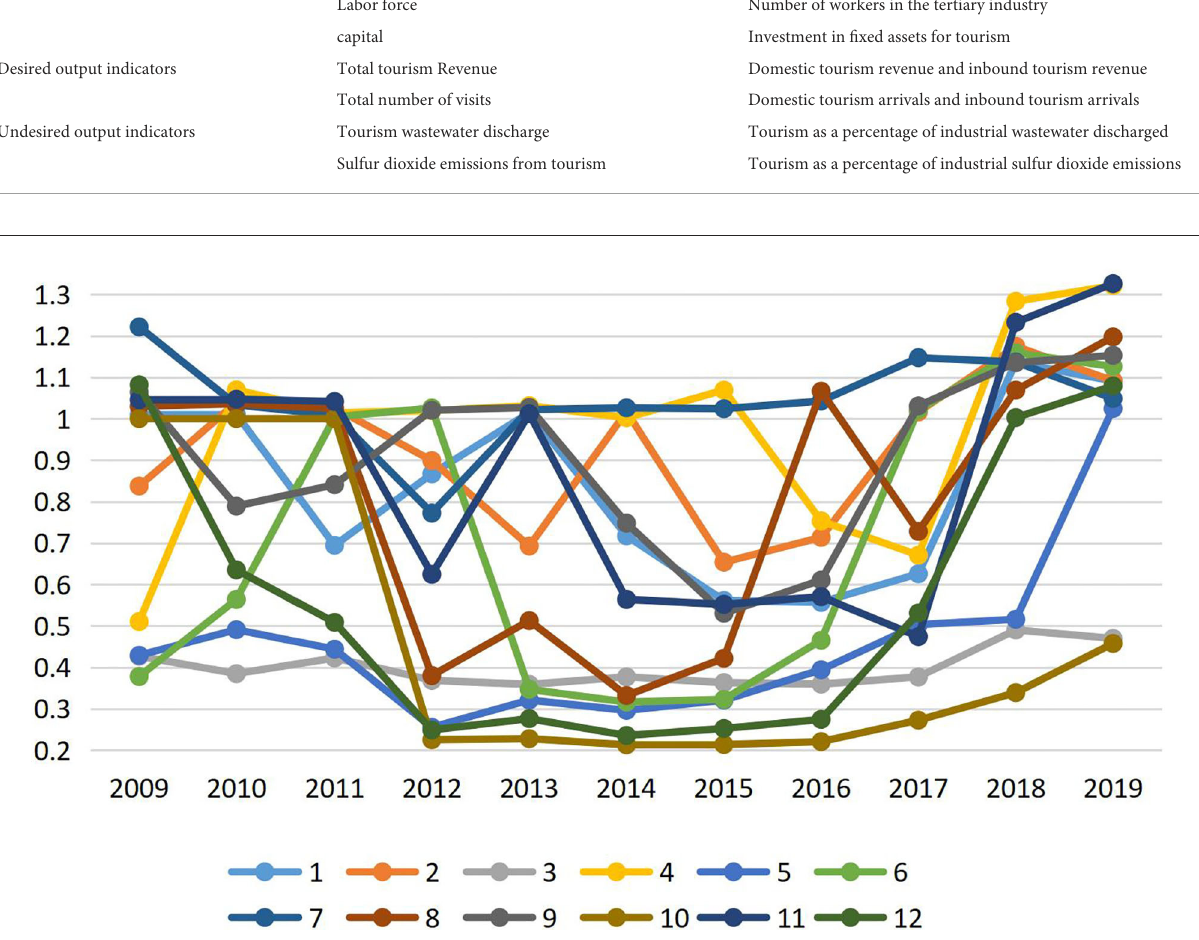
FIGURE1 Tourism eco-efficiency in Inner Mongolia from 2009 to 2019. Hohhot City, Baotou City, Hulunbuir City, Xing‘an League, Tongliao City, Chifeng City, Xilin Gol League, Ulanqab City, Ordos City, Bayannur City, Wuhai City, and Alxa League are represented by numbers 1–12.